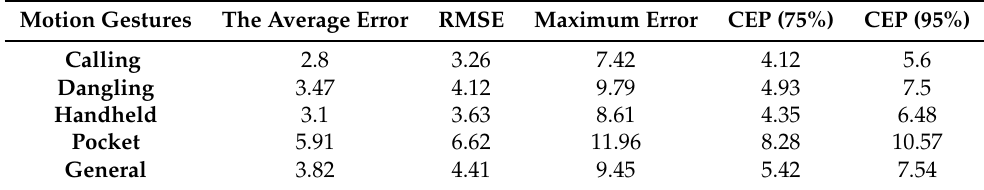
Table 3. Position errors for DR/MM (m) in office